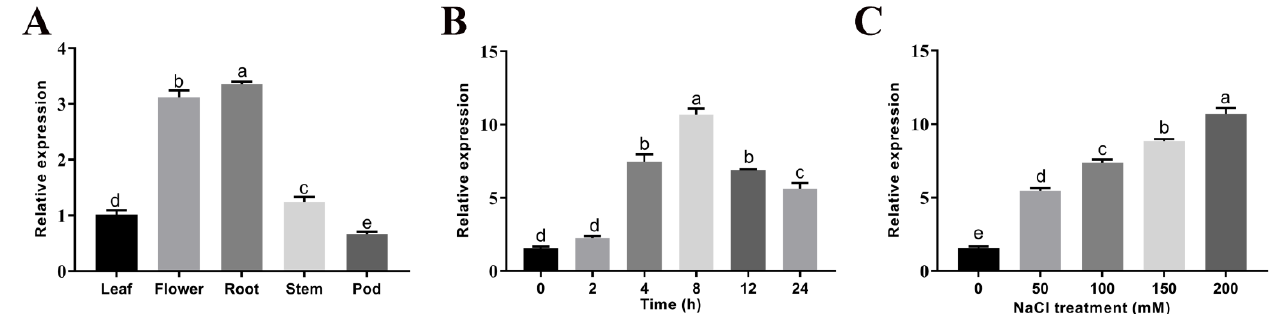
Figure 2. Determination of GmGSTU23 expression patterns. ( A ) The relative expression of GmGSTU 23 in different organs of soybean plants. ( B ) Time-dependent expression pattern of GmGSTU23. The plant materials were collected after 0, 2, 4, 8, 12, and 24 h in 200 mM NaCl. ( C ) Dose-dependent expression pattern of GmGSTU23 . The seedings were measured after exposure to 0, 50, 100, 150, and 200 mM NaCl for 8 h. Different letters above the bars indicate significant differences among the treatments ( p < 0.05).